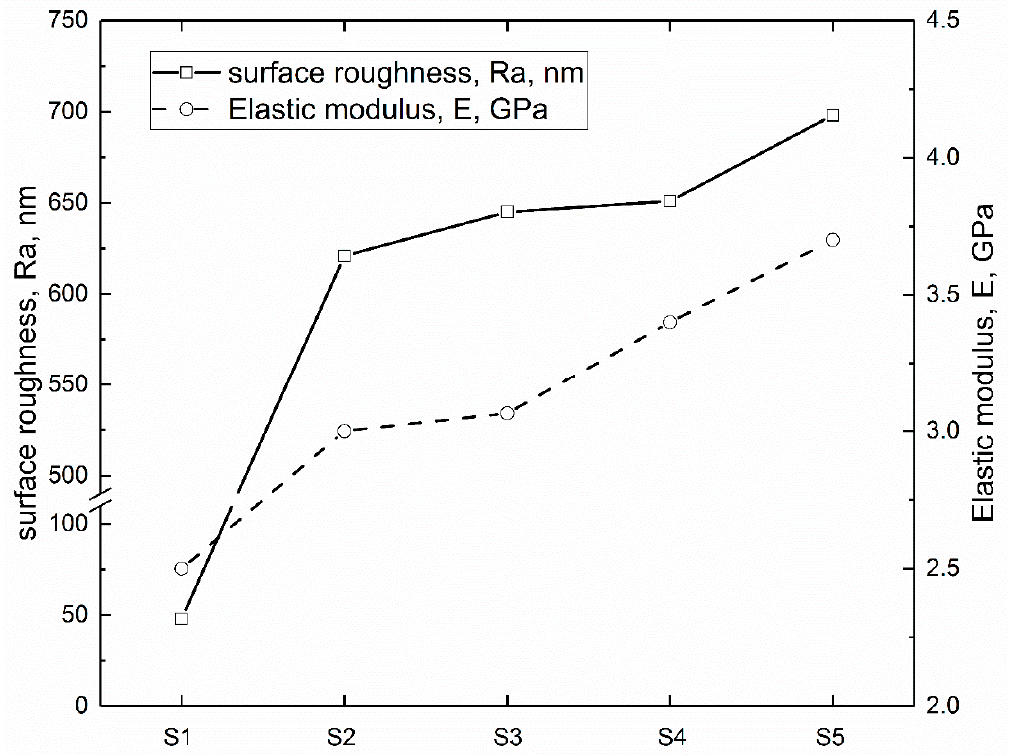
Figure 1. Variations of surface roughness (Ra) and Derjaguin-Muller-Toporov (DMT) elastic modulus (E) of the PEEK based coatings.